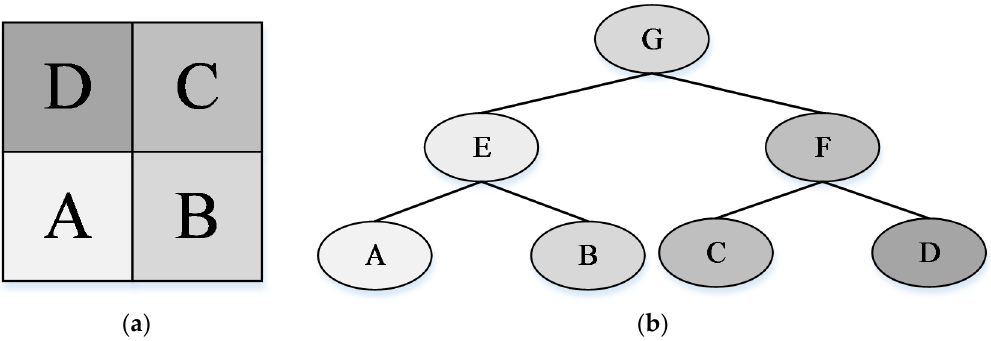
Figure 2. Schematic map of the Binary Partition Tree (BPT) construction. ( a ) Original image with 4 regions; ( b ) The construction of the BPT.